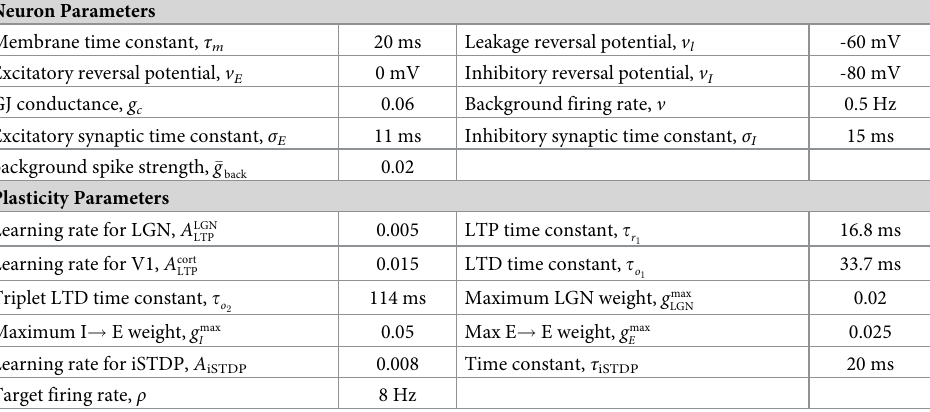
Table 1. Model parameter values parametrized for the visual cortex. See text for